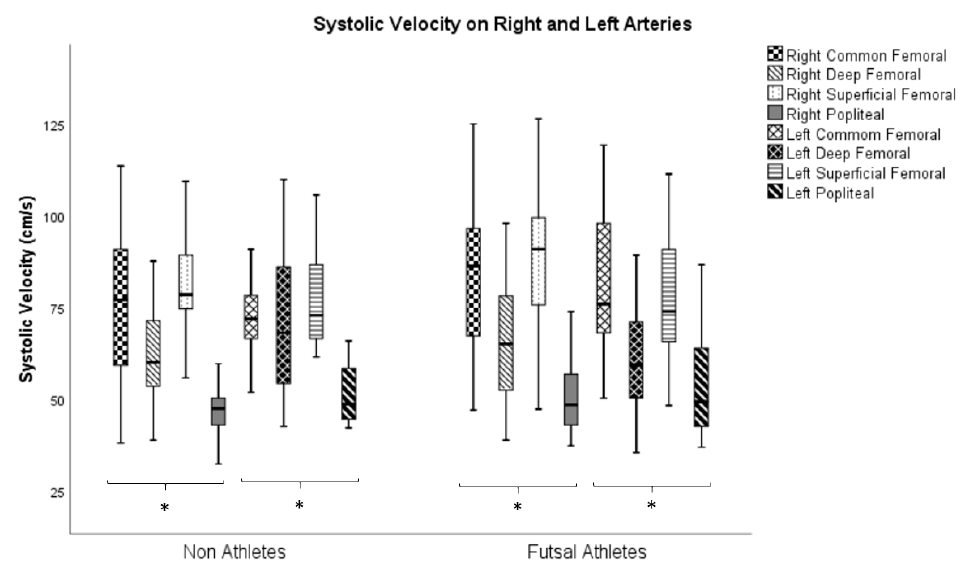
Figure 3. Analysis of the systolic velocities variance on right and left arteries in non-athletes and futsal athletes (* p ≤ 0.05—Friedman’s Test).